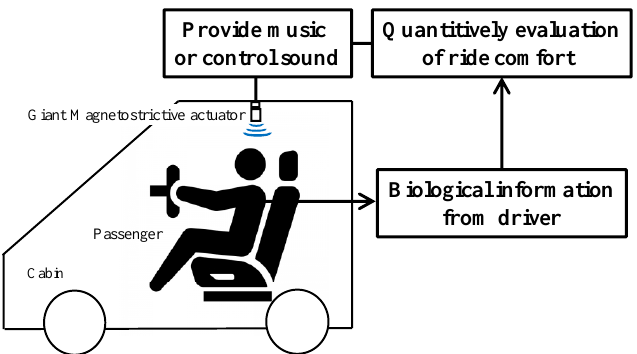
Figure 3. Active noise control (ANC) system for ultra-compact electric vehicle (EV) using giant magnetostrictive actuator (GMA) in future.